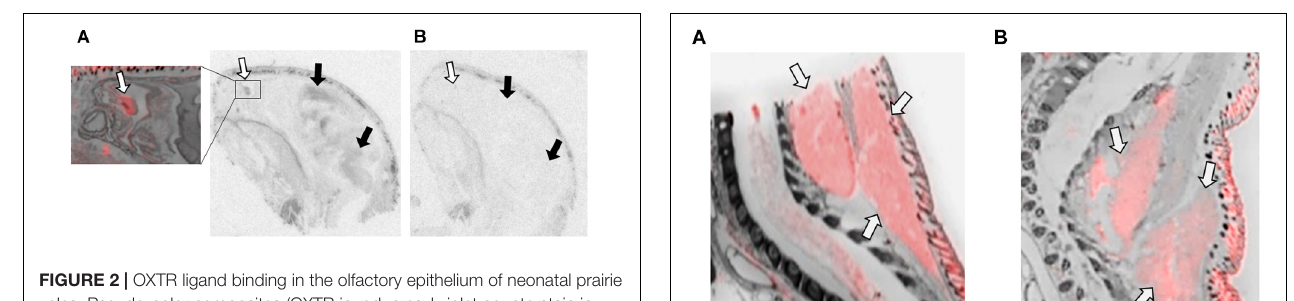
FIGURE 2 | OXTR ligand binding in the olfactory epithelium of neonatal prairie voles. Pseudo-color composites (OXTR in red, cresyl violet counterstain in gray) of neonatal prairie vole with 0 nM OXT competition. White arrows indicate nasal turbinates; quantifications were measured from surface area of nasal epithelium. Black arrows indicate brain regions with (A) specific OVTA-ligand binding and (B) an adjacent slice with 1000 nM unlabeled OXT competition.